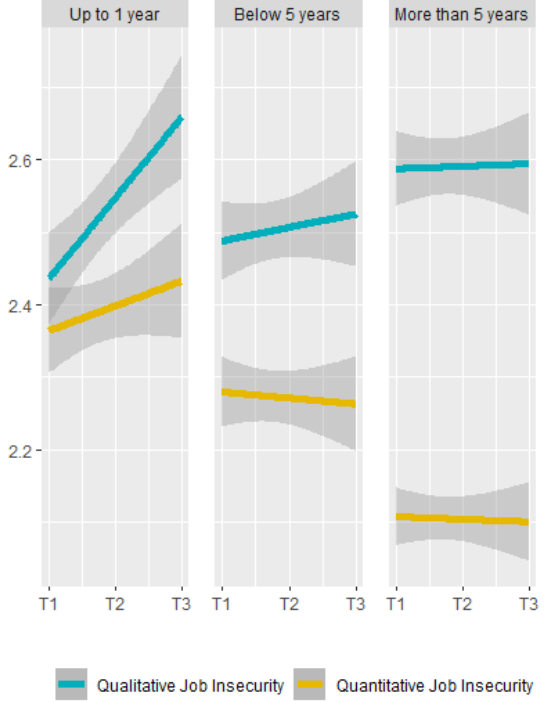
Figure A5. Positional tenure.